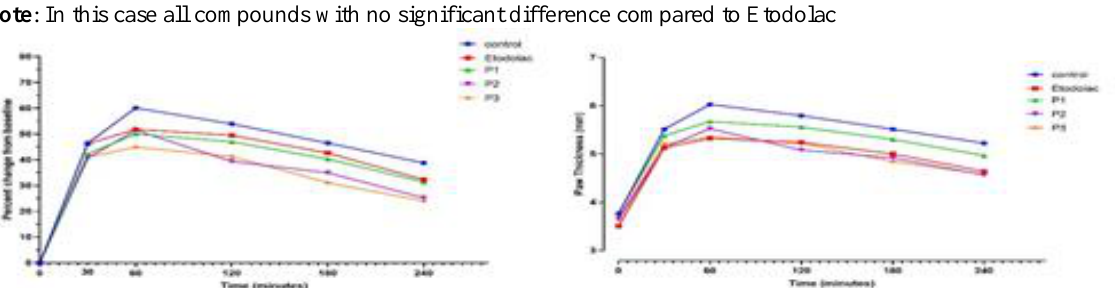
Data are expressed in mm paw thickness as mean ±